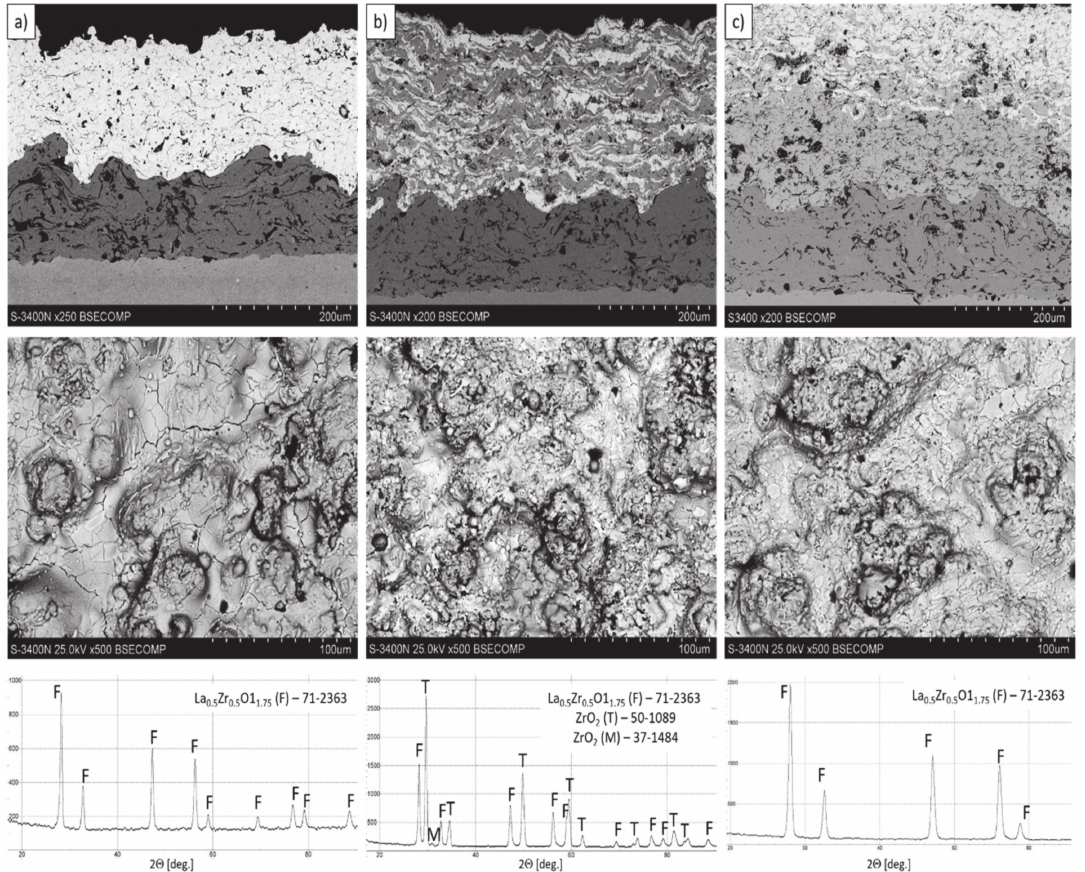
Figure 5. The cross-section microstructure, surface topography, and phase composition of TBC systems: ( a ) monolayered La 2 Zr 2 O 7 , ( b ) composite 50% La 2 Zr 2 O 7 + 50% 8YSZ, and ( c ) DCL La 2 Zr 2 O 7 / 50% La 2 Zr 2 O 7 + 50% 8YSZ /